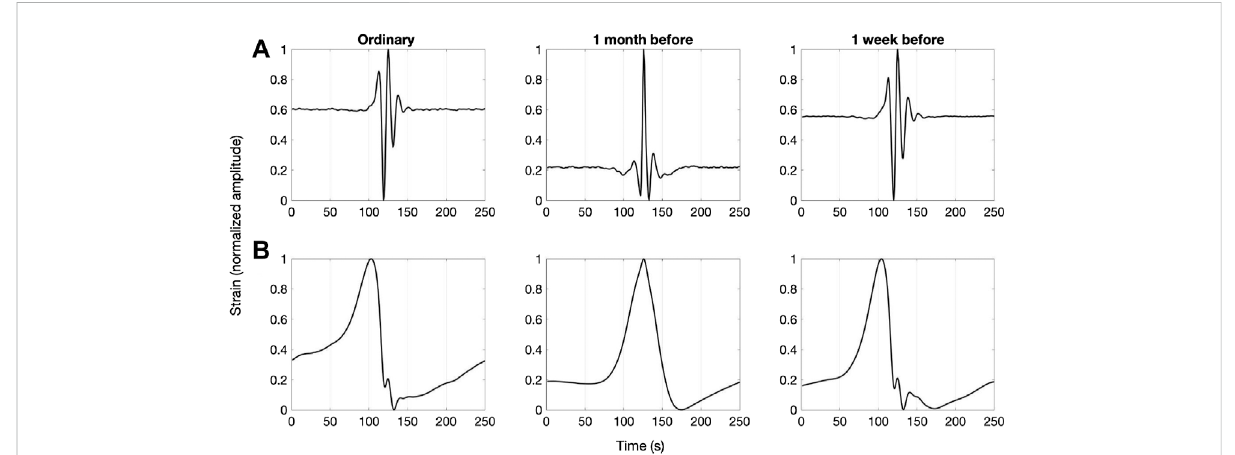
FIGURE 2 (A) Normalized stacked VLP waveforms for three time periods of the whole year 2019: “ ordinary ” volcano activity present before (from January to May) and after (from July to December) 2019 eruptive activity, 1 month and 1 week before 3 July paroxysm. (B) Normalized stacked ULP waveforms for the same three time